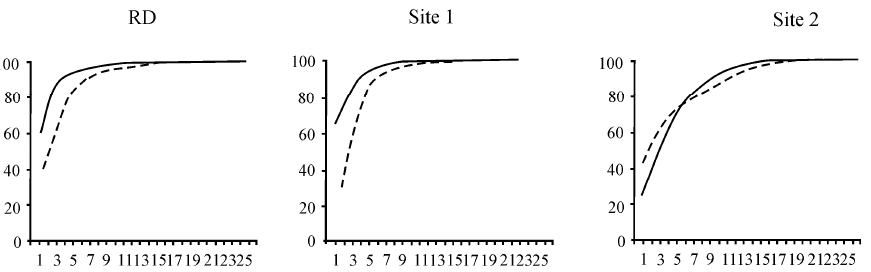
Figure 5. The k-dominance curves characterising the state of the zooplankton community in the coastal zone of Lake Baikal: RD—zooplankton community characterised as stable in the early period; Site 1—zooplankton community characterised as stable in the background area; Site 2—zooplankton community characterised as moderately disturbed in the area with human activity. The ordinate axis is the cumulative % of biomass (1) and abundance (2) of species, and the abscissa axis is the sequence of zooplankton species ranked in descending order.